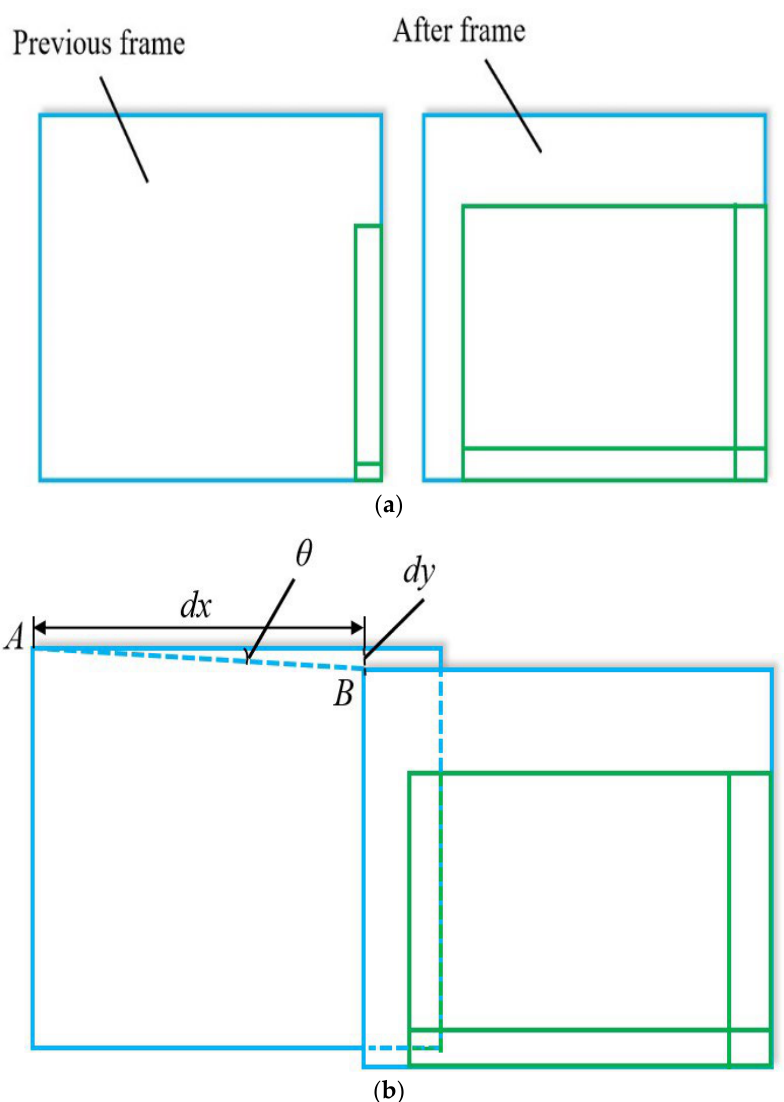
Figure 5. Calculation of the misalignment angle. ( a ) Two adjacent frames; ( b ) Image mosaic.